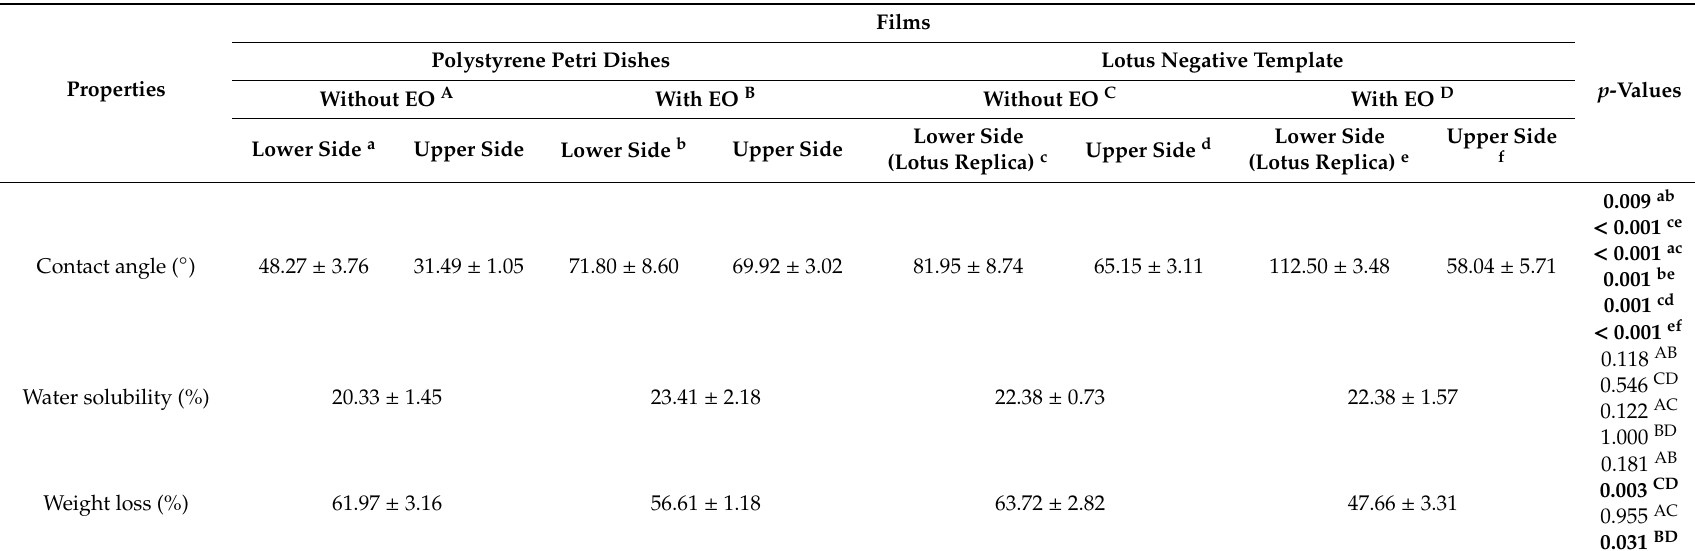
Table 3. Contact angle, water solubility and weight loss of the